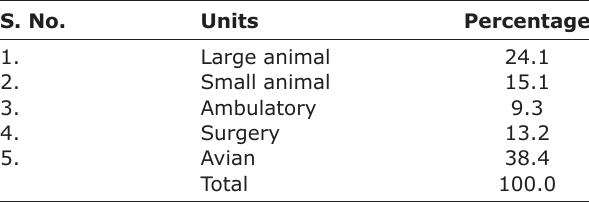
Table-2: Percentage of use of antibiotics in each unit of the